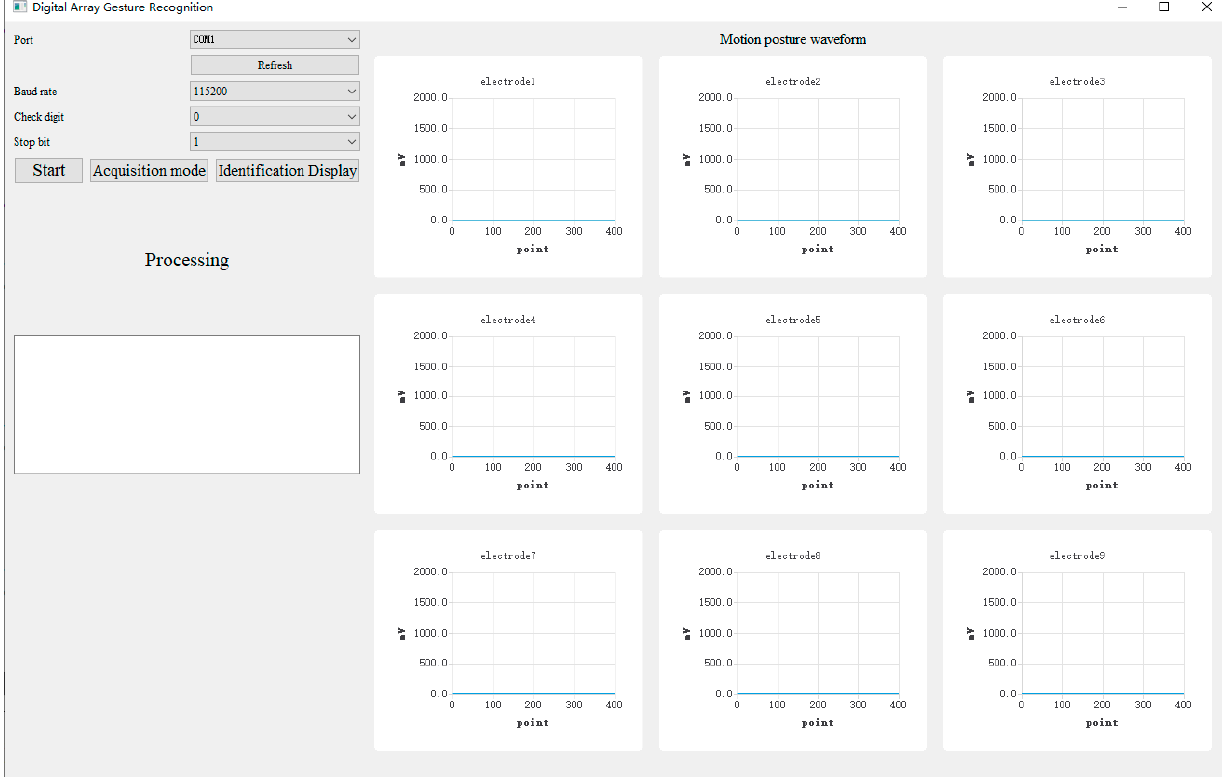
Sensors 2022 , 22 , 1158 Figure 5. Main window of the application. Figure 5. Main window of the application.